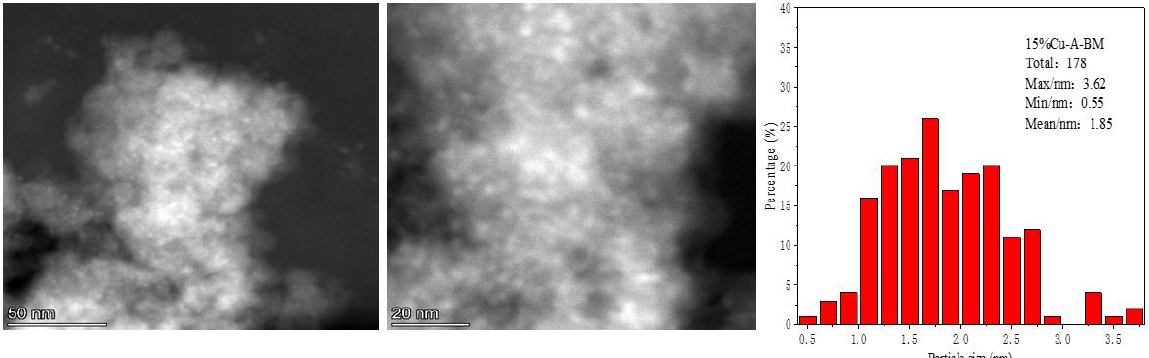
Figure 8. HAADF-STEM and particle size statistics of 15% Cu-A-BM catalyst.